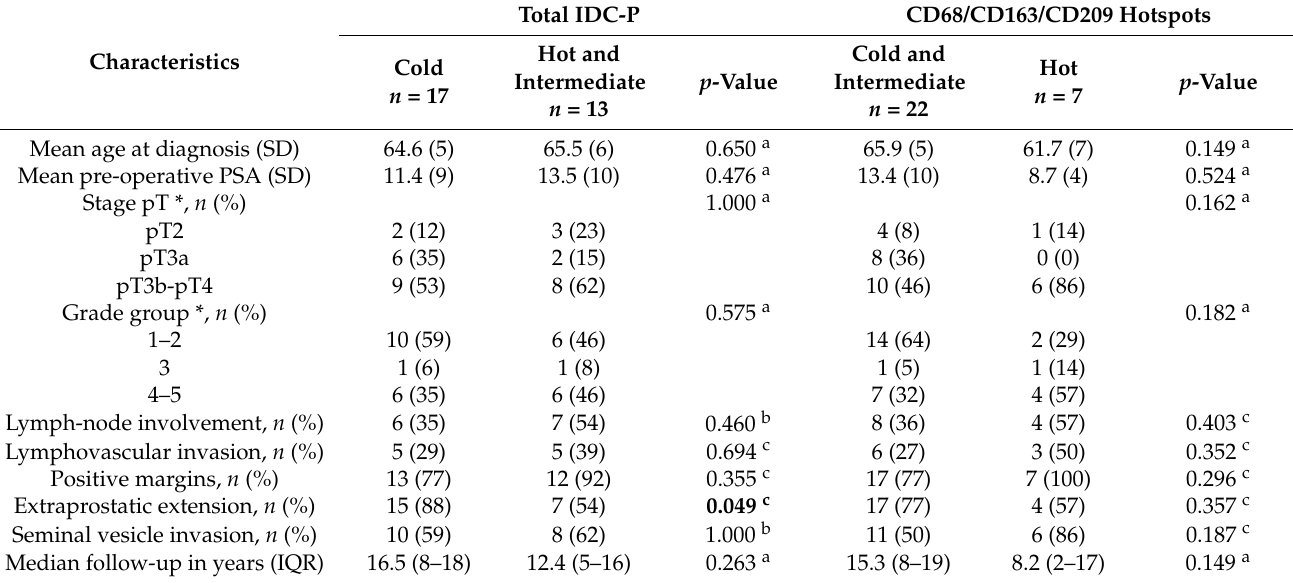
Table 3. Association of clinical and pathological variables with immunologically “cold”, “intermedi- ate” or “hot”